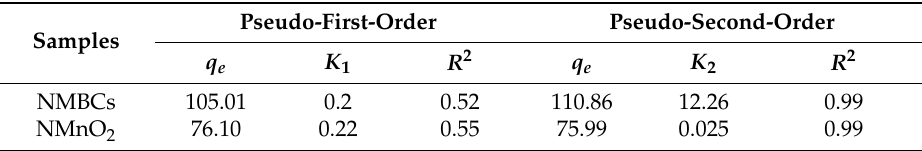
Table 2. Parameters of the pseudo-first-order and pseudo-second-order models for the adsorption of Cu(II) by NMBCs and NMnO 2 .